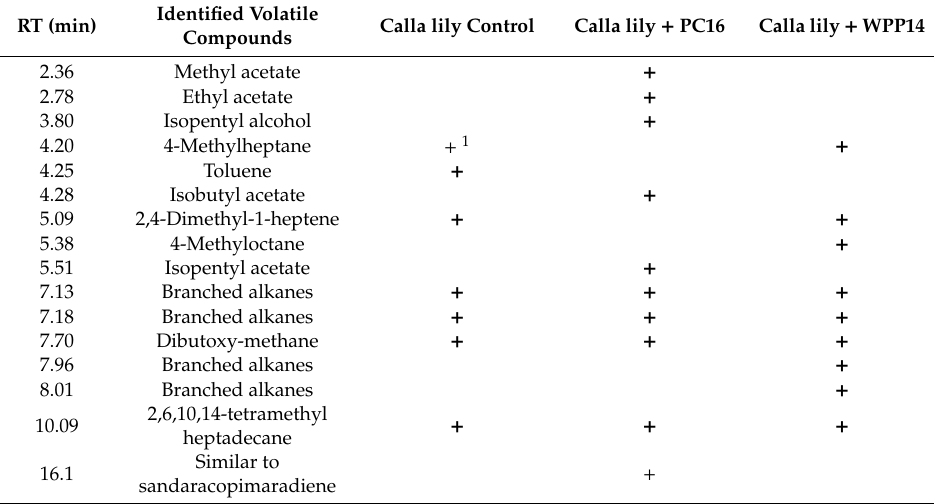
Table 3. VOCs collected from the headspace of calla lily samples inoculated with PC16 or WPP14 and the corresponding control (DDW), as identified by